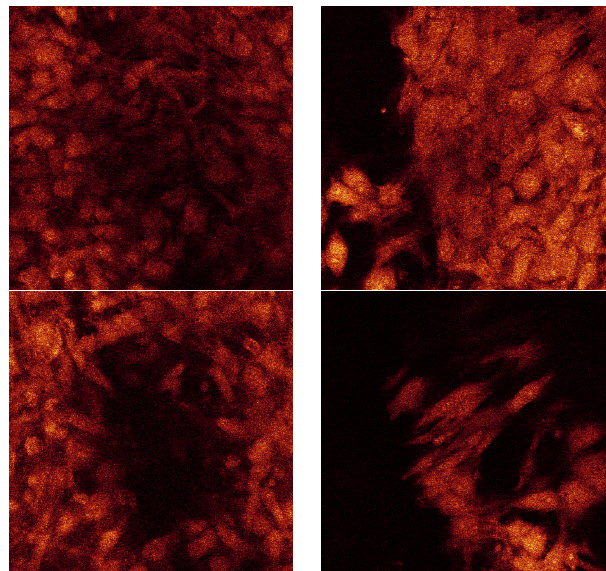
Figure 14. Confocal raw data series taken at random distance through the cell layer on the SBF coating on less porous alumina Sample B.